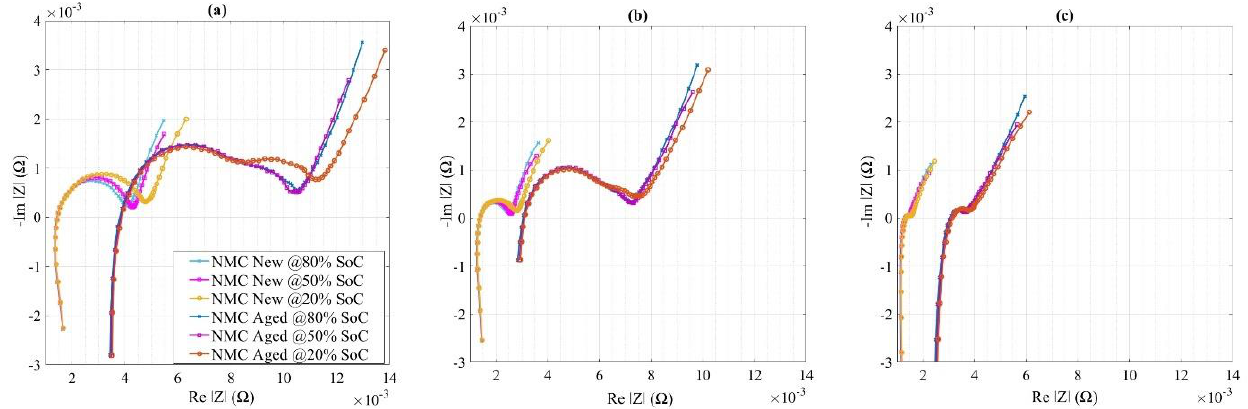
Figure 9. Nyquist plots for new and aged NMC cells at ( a ) 15 °C, ( b ) 25 °C, and ( c ) 45 °C.